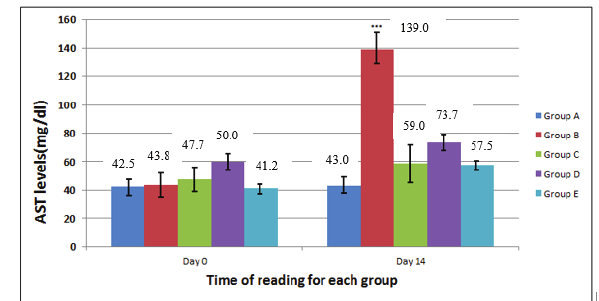
Fig-2: Effect of Ajwa date on AST (mean ± SD) of ATT induced hepatotoxic rabbits (n=6) Group A: Normal Control, Group B: Anti-tuberculous drugs (ATT), Group C: ATT + Whole Ajwa Date, Group D: ATT + Ajwa Date Flesh, Group E: ATT + Ajwa Date Seed Powder